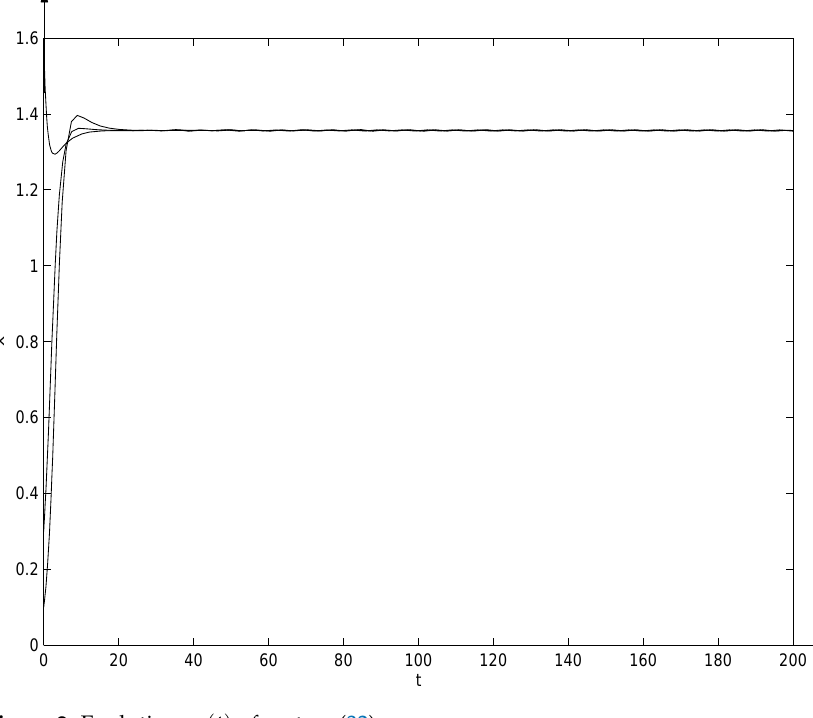
Figure 2. Evolutions x ( t ) of system